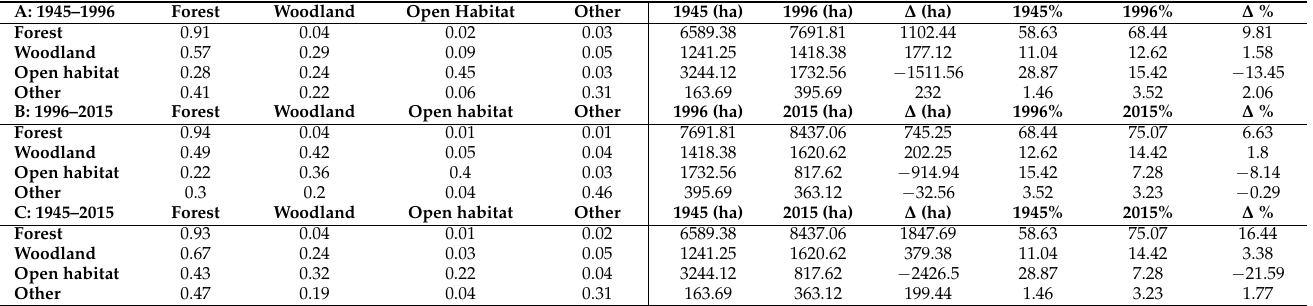
Table 2. Transition matrices of LULC classes in the study area (left part of the table) for the periods 1945 to 1996 (A), 1996 to 2015 (B) and 1945 to 2015 (C). Transition matrix values represent the percentage cover of LULC classes. The right part of the table (separated from the left part by a vertical line) presents the area of each land cover class (in hectares and in percentage of total surface of the study area) at the starting and end years of the period, as well as the difference between them (again in hectares and percentage